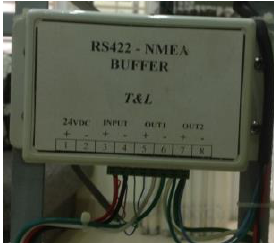
Fig. 5. NMEA0183 signal buffer.